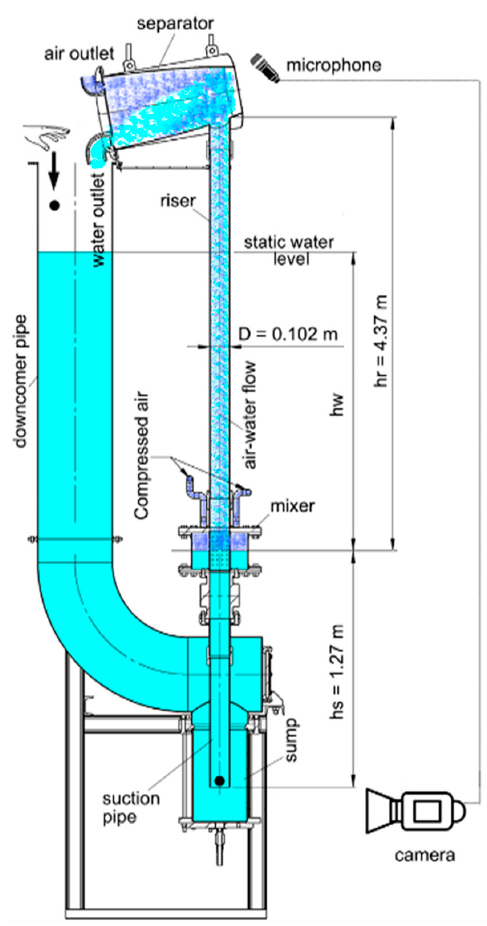
Figure 1. Schematic of the working principle of the airlift pump.